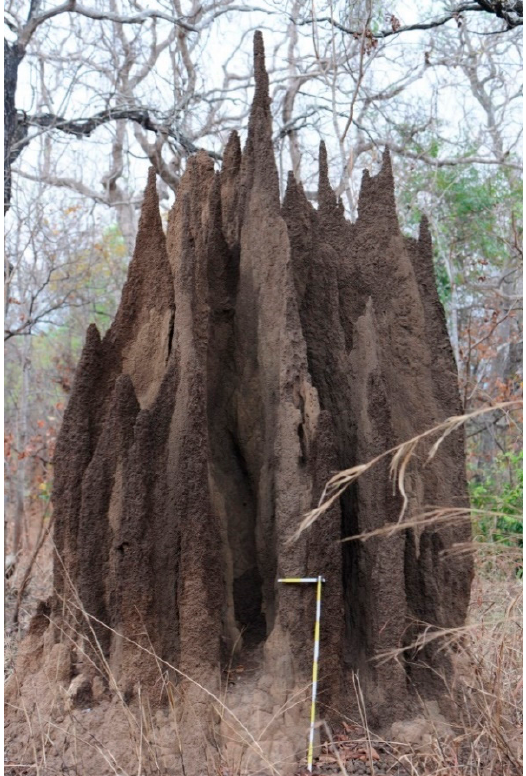
Figure 1. Termites do not only build charismatic mounds but also function as important ecosystem engineers in the tropics and subtropics.